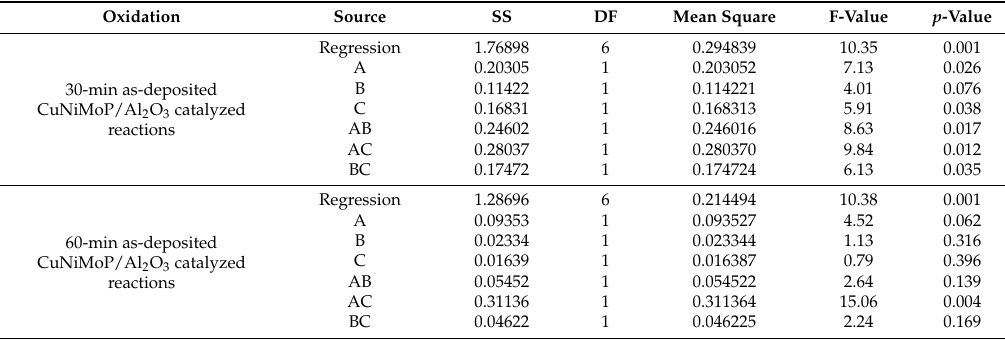
Table 7. ANOVA results for glyceric acid production.